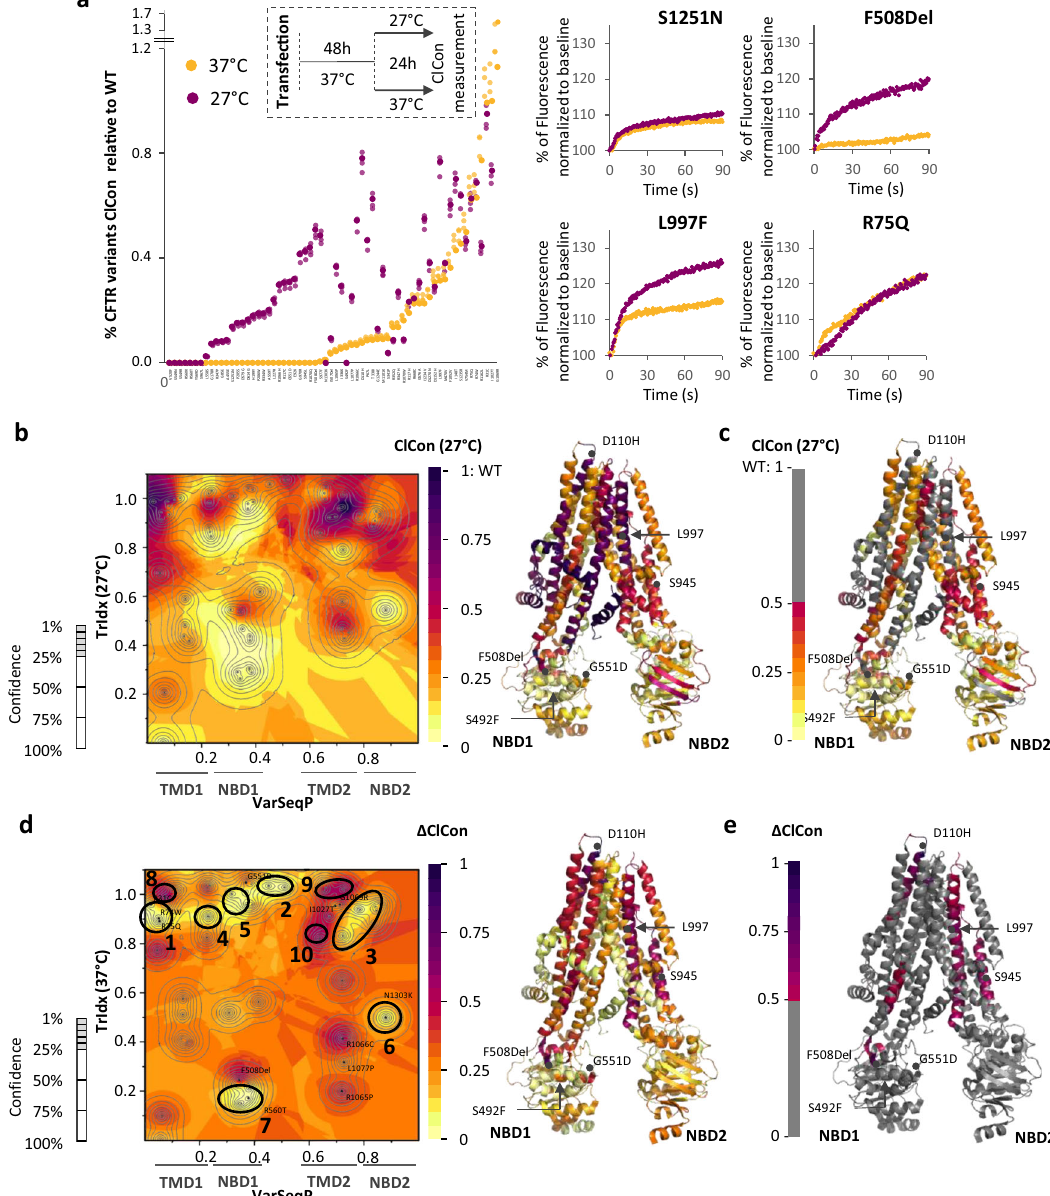
Fig. 5 Contribution of SCV to CFTR energetics driving function at the cell surface. a % of variant function relative to WT at 37°C (orange) and 27°C (blue); the variants are ordered from the lowest to the highest function measured at 37°C (left panel; n = 3 biological replicates). Representative FMP traces of S1251N, F508Del, L997F and R75Q variants after 24h at 37°C (orange) or 27°C (blue) (right panel). b (Left panel) ClCon-phenotype landscape at 27°C using the VSP-predicted values relating TrIdx (band C/total (B + C) ratio; y -axis) and ClCon ( z -axis) in the context of sequence position (VarSeqP, x -axis) overlaid with the con fi dence contour intervals. (Right panel) ClCon-associated functional structure at 27°C. c Grayout of panel B, ClCon functional structure at 27°C showing only residues with <50% of WT measured value. The grayout structure highlights in a color gradient the known and predicted unknown residue functions that are likely to contribute to reduced ClCon at 27°C. d (Left panel) Δ of the temperature shift of ClCon (TS Δ ClCon) phenotype landscape using the VSP-predicted values of the Δ ClCon between 27°C and 37°C ( z axis) relating to the TrIdx at 37°C in the context of sequence position (VarSeqP, x-axis) overlaid with the con fi dence contour intervals. (Right panel) TS Δ ClCon-phenotype landscape de fi ned functional structure. e Grayout of panel B, TS Δ ClCon functional structure showing only residues with more than 50% of relative correction. Maximal Δ ClCon (70% of WT) is set as 1.0 (Fig. 5d, e). The grayout structure highlights in a color gradient the known and predicted unknown residue functions that are likely to display ClCon correction in response to reduced